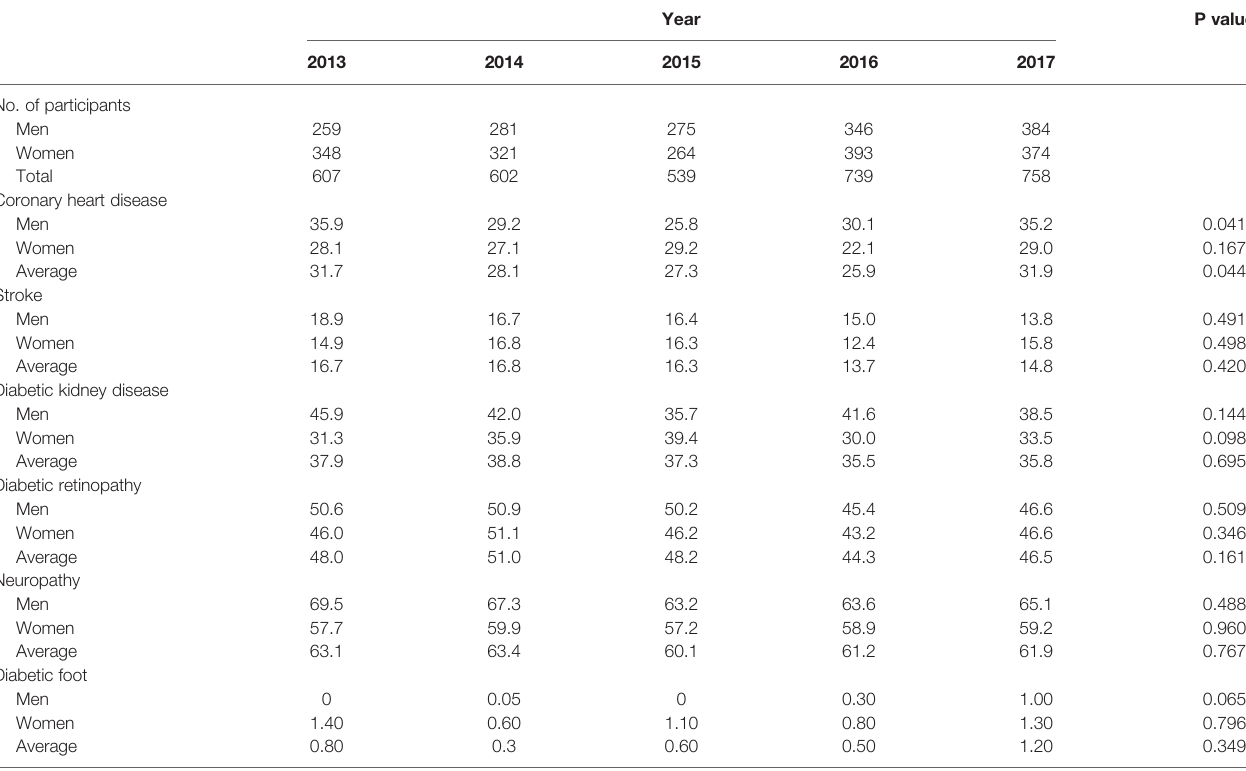
TABLE 4 | Prevalence of major diabetic complications among inpatients with type 2 diabetes in Tianjin General Hospital from 2013 to